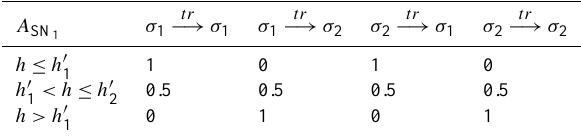
. Table 5. Matrix of state-transition probabilities A SN 1